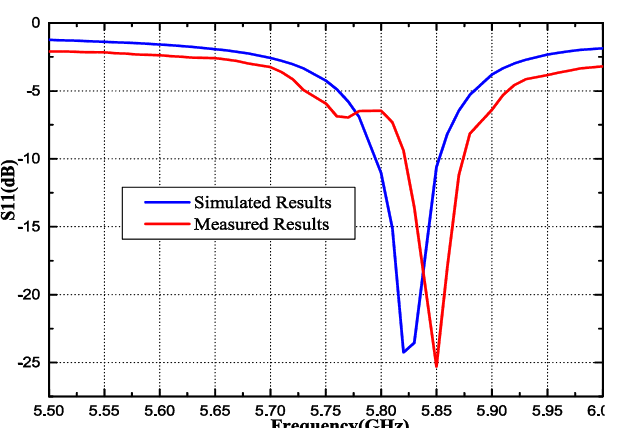
Figure 14: simulated and measured return loss at 6 GHz